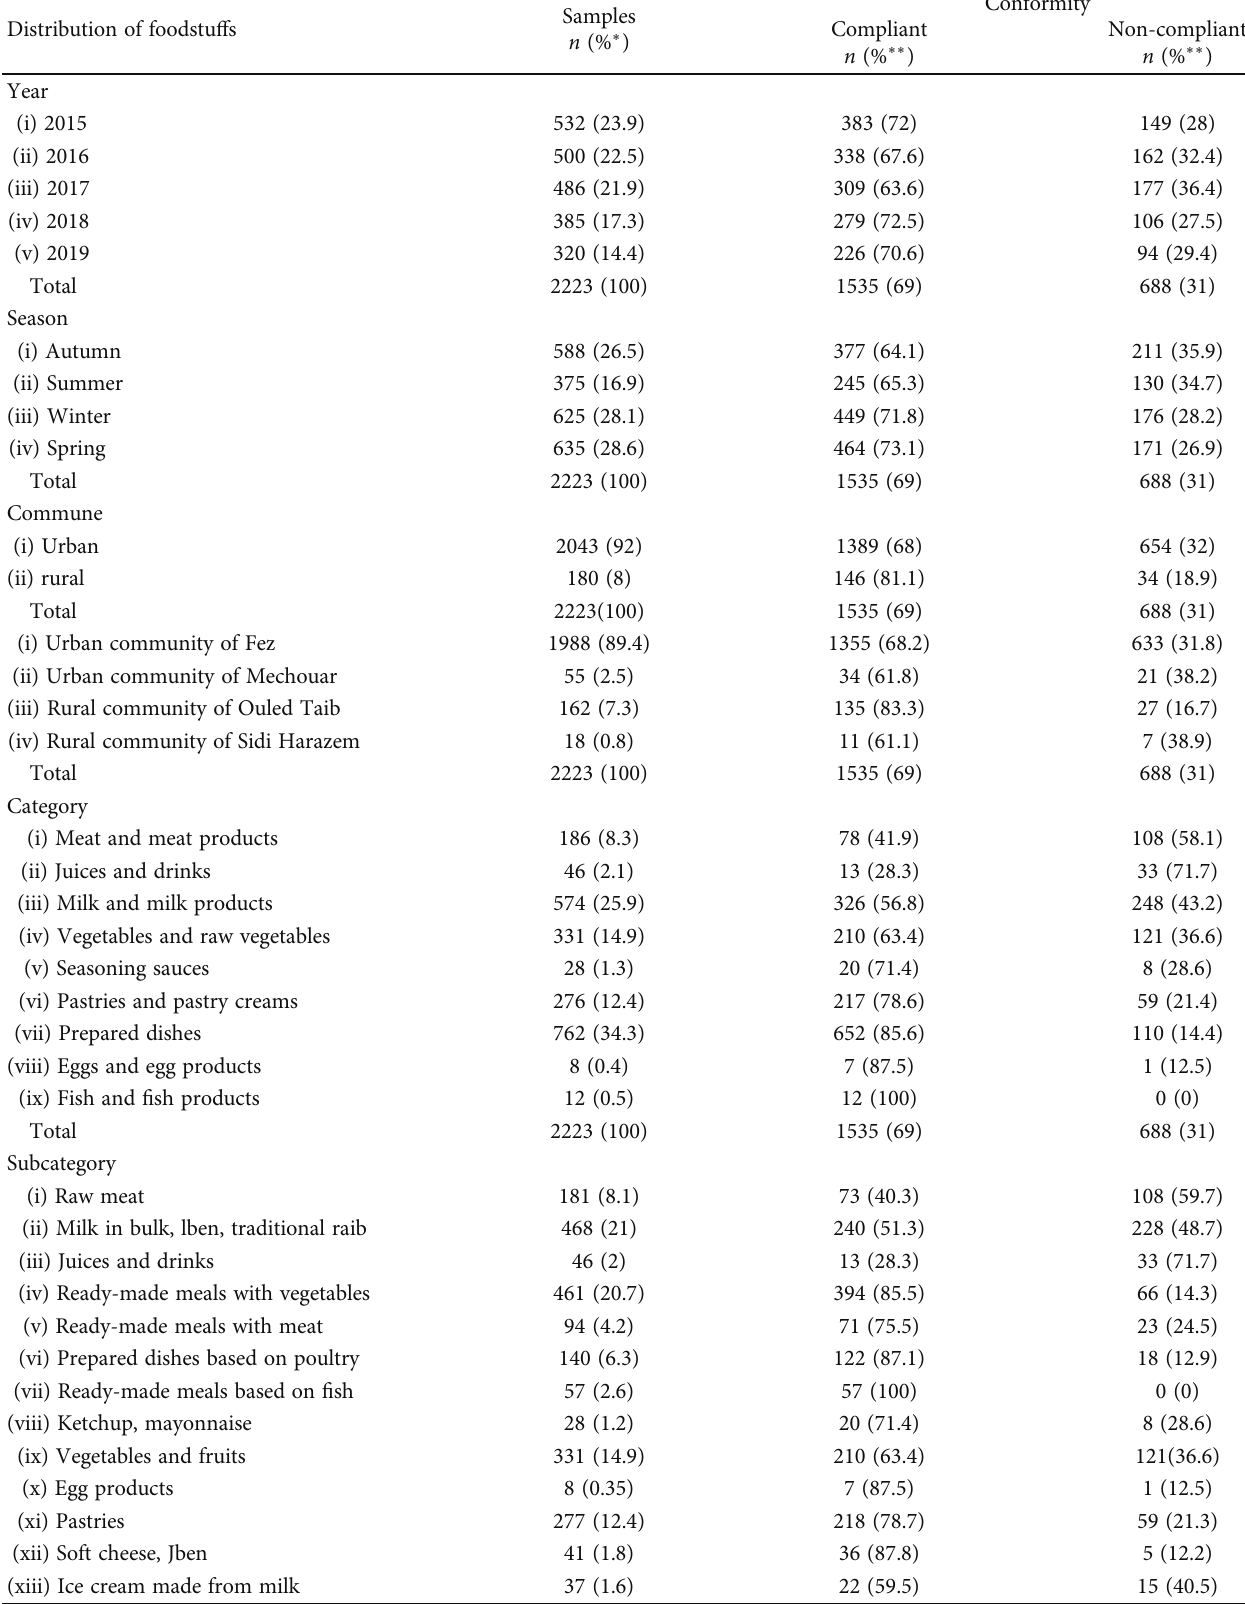
Table 1: Percentage and frequency of non-compliance of foodstu ff s analyzed during the study period. Distribution of foodstu ff